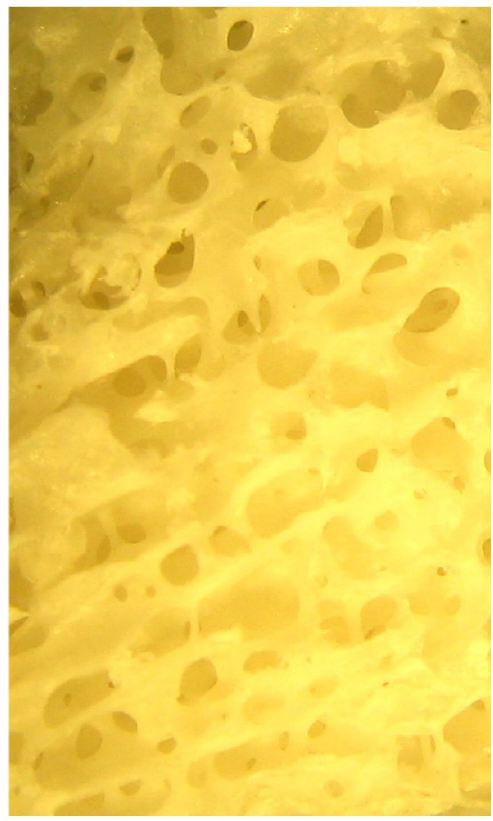
Figure 2: Highly purified bone offers the advantages of 1. Increased safety, 2. Accelerated incorporation, and 3. Enormous reservoir / surface available for storage and adhesion of antimicrobial substances . Stored antibiotics are able to diffuse through the open canaliculi, providing controlled release over weeks after